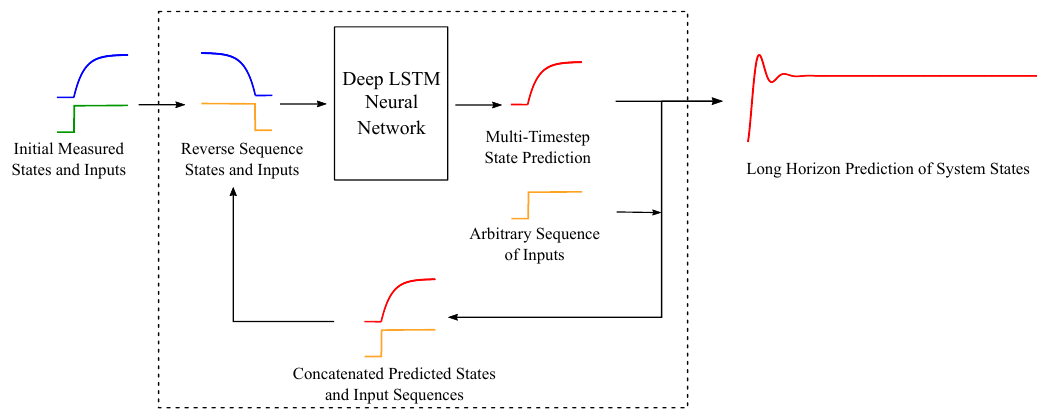
Figure 1. A schematic illustrating the overall data-driven approach developed in this paper for multi-timestep predictions of high-dimensional dynamical systems’ behavior over a long time-horizon. An initial sequence of states and inputs are fed to the ”Stacked LSTM Network” in a reverse-order for multi-timestep prediction of the system’s states (”Reverse-order sequence-to-sequence mapping”). The predicted output from each stacked LSTM network is concatenated with the next sequence of inputs and fed into the next stacked LSTM network in a reverse-order to increase the predictive horizon. This process is iterated an arbitrary number of times, creating long dynamical